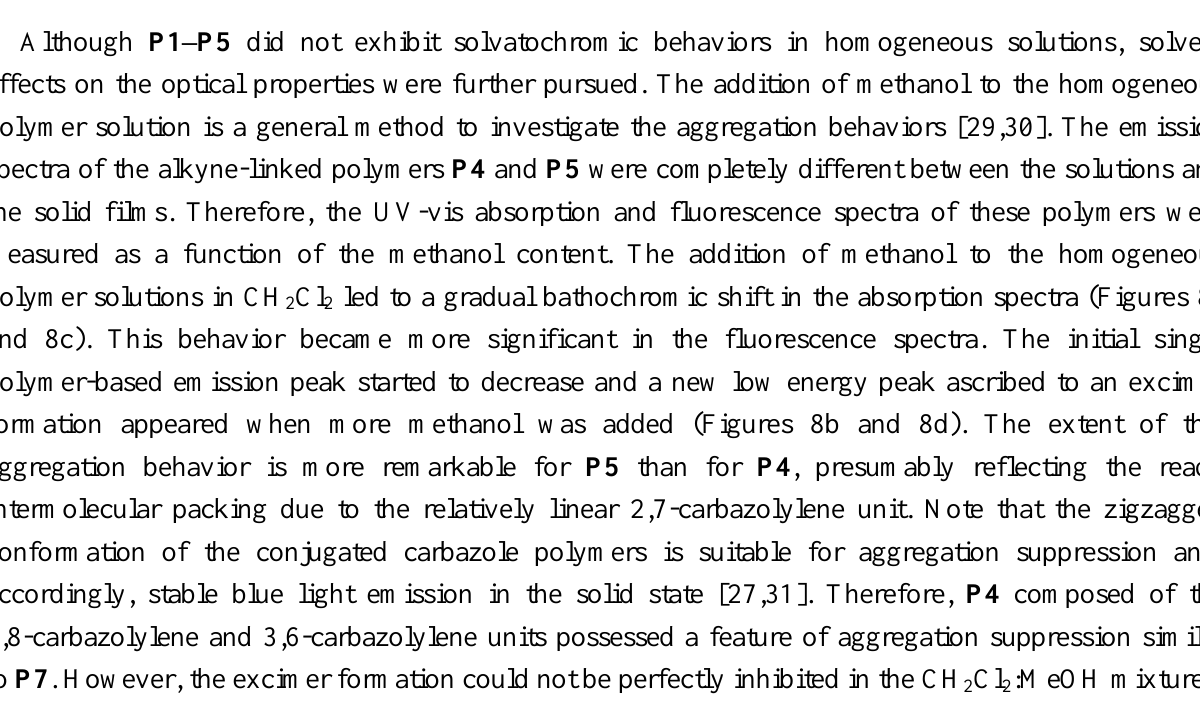
Figure 8. Solvatochromic behaviors of UV-vis absorption ( a , P4 ; c , P5 ) and fluorescence spectra ( b , P4 ; d , P5 ) in CH